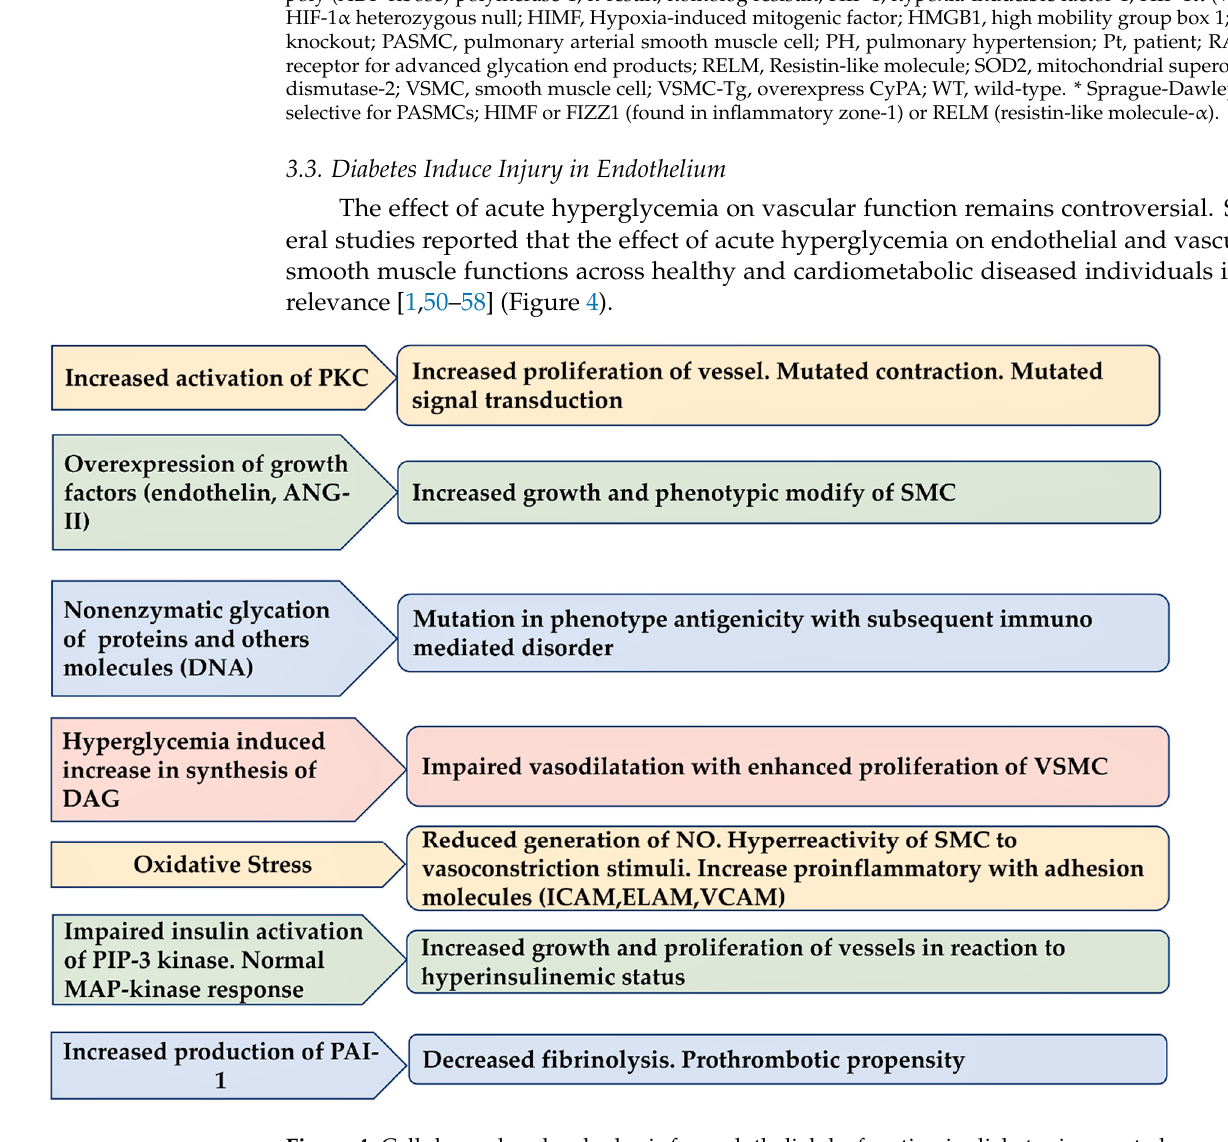
Figure 4. Cellular and molecular basis for endothelial dysfunction in diabetes is reported.